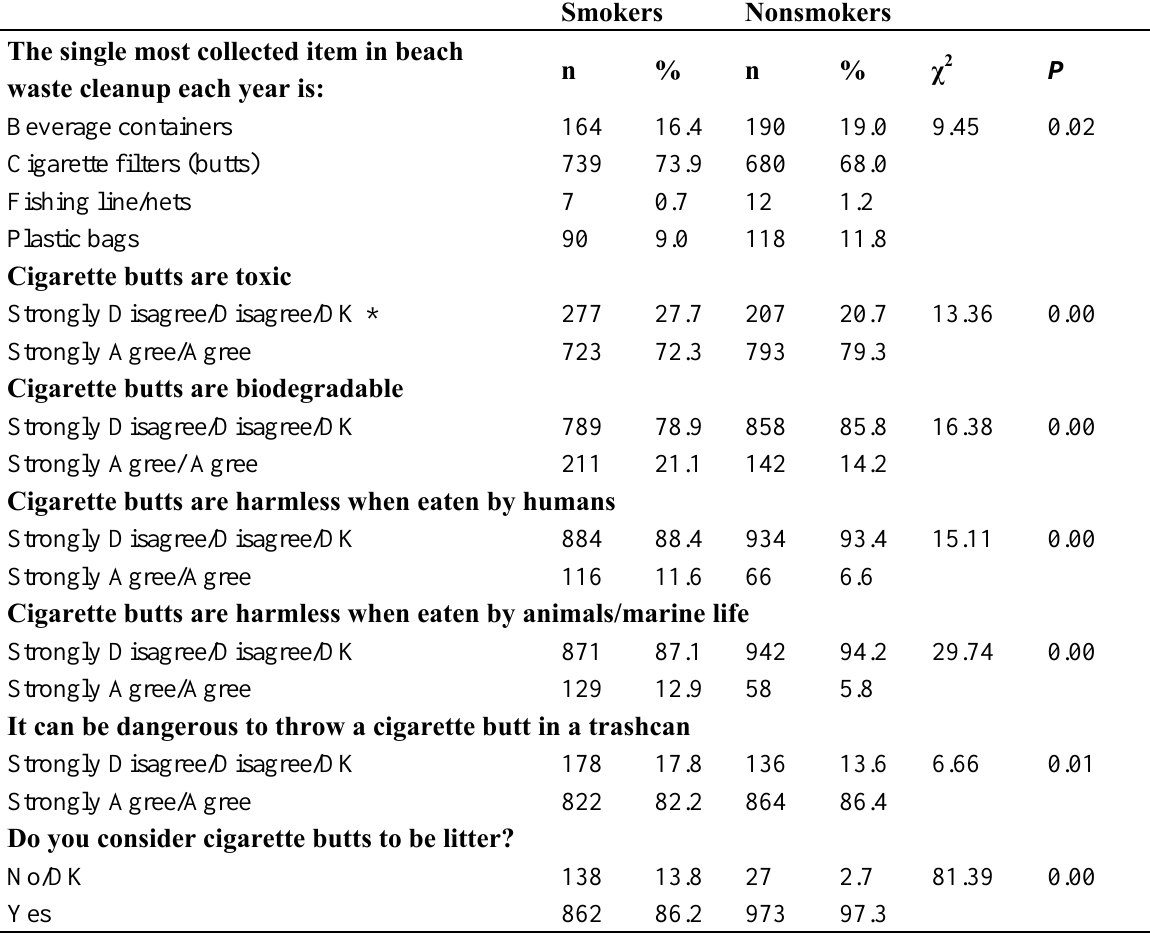
Table 2. Attitudes and beliefs about cigarette butts as litter (n = 1,000 smokers & 1,000